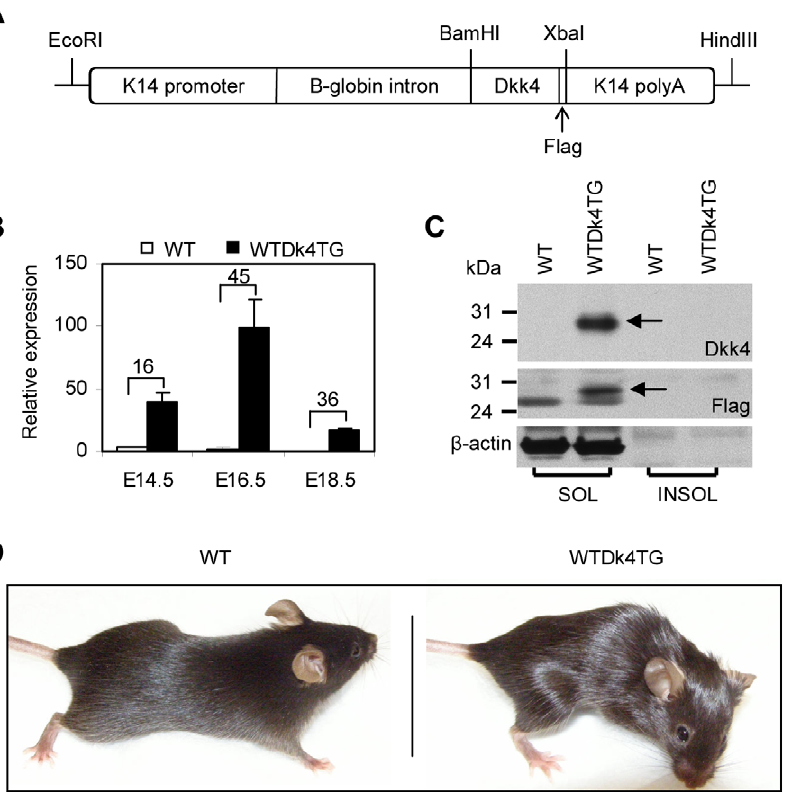
Figure 1. The WTDk4TG mice have a rough hair coat. A, Dkk4 transgene structure. Full-length mouse Dkk4 cDNA with a Flag sequence in the 3 9 end was inserted into a K14 vector using BamHI and XbaI sites. The linearized EcoRI/HindIII transgene fragment was used for microinjection. B, Transgene expression was sharply up-regulated from E14.5. C, Increased Dkk4 protein production was detected in the soluble fraction (SOL) of WTDk4TG skin at E16.5 in Western blotting analysis with antibodies against Dkk4 and Flag (arrows). D, WTDk4TG mice at 2 months of age. The hair coat in transgenic mice is rough.